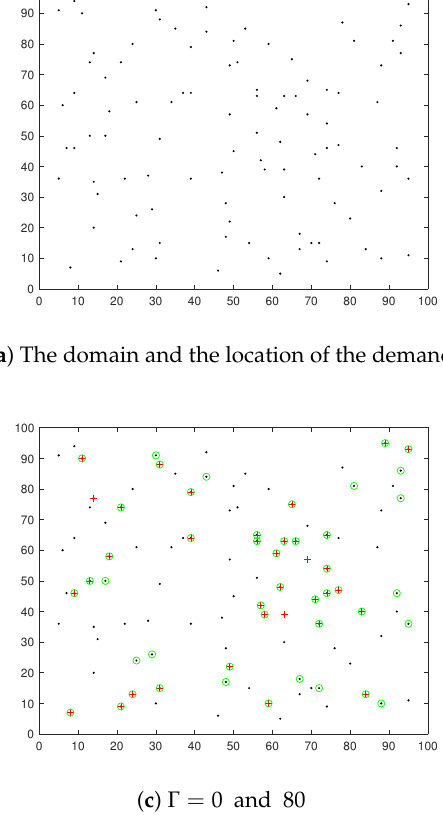
Figure 1. The location of demand and optimal solution of